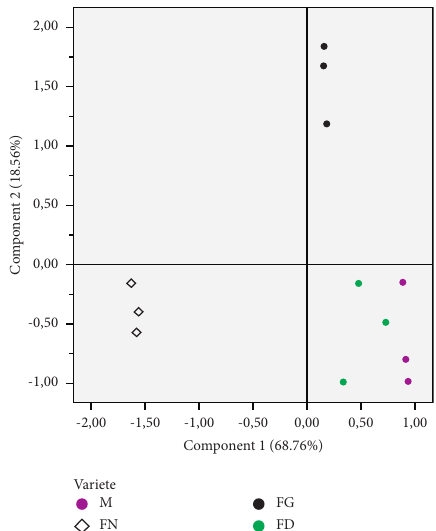
Figure 2: The dispersion of the four almond oils of the studied varieties in the plane defined by two principal components (M � Marcona , FN � Fournat , FG � Ferragnes , and FD � Ferraduel